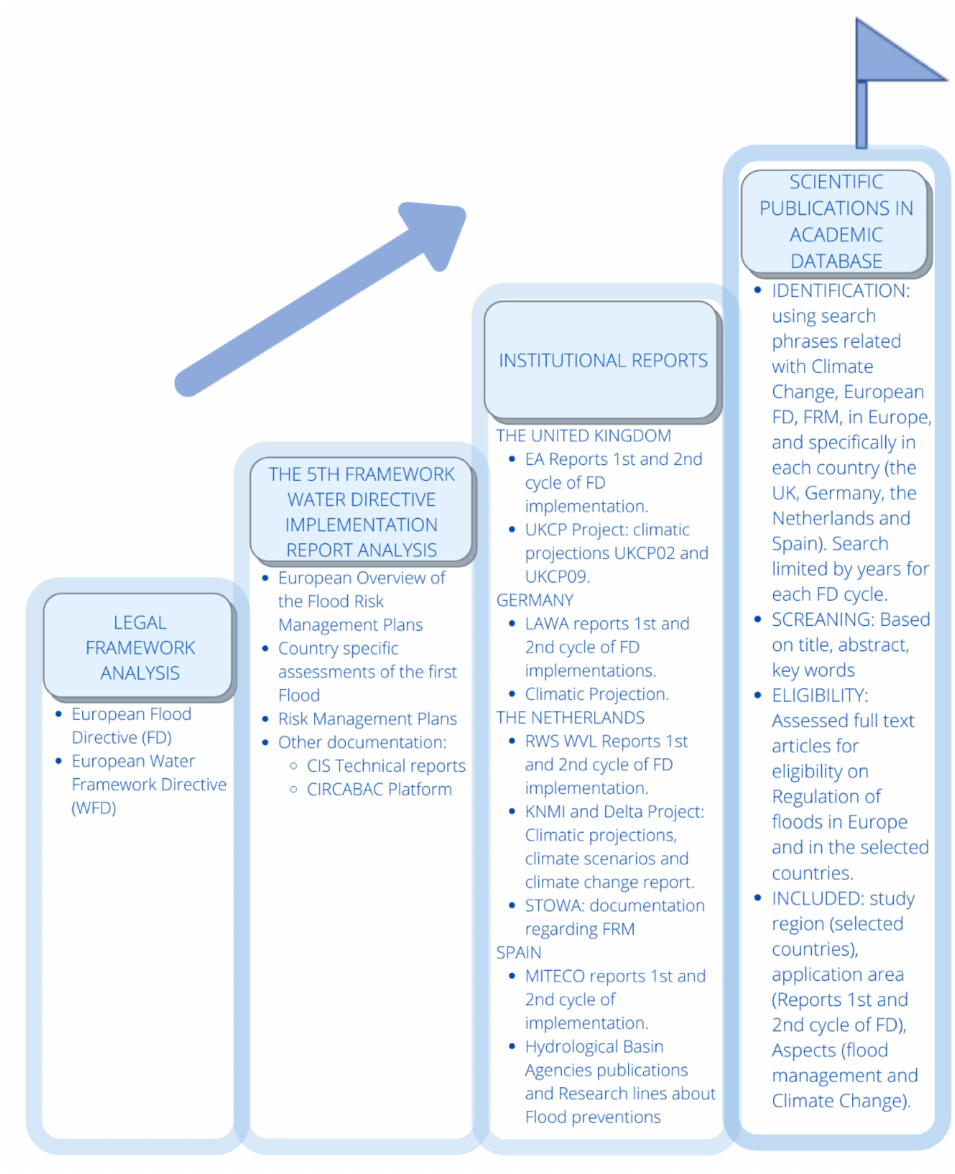
Figure 2. Bibliographic research